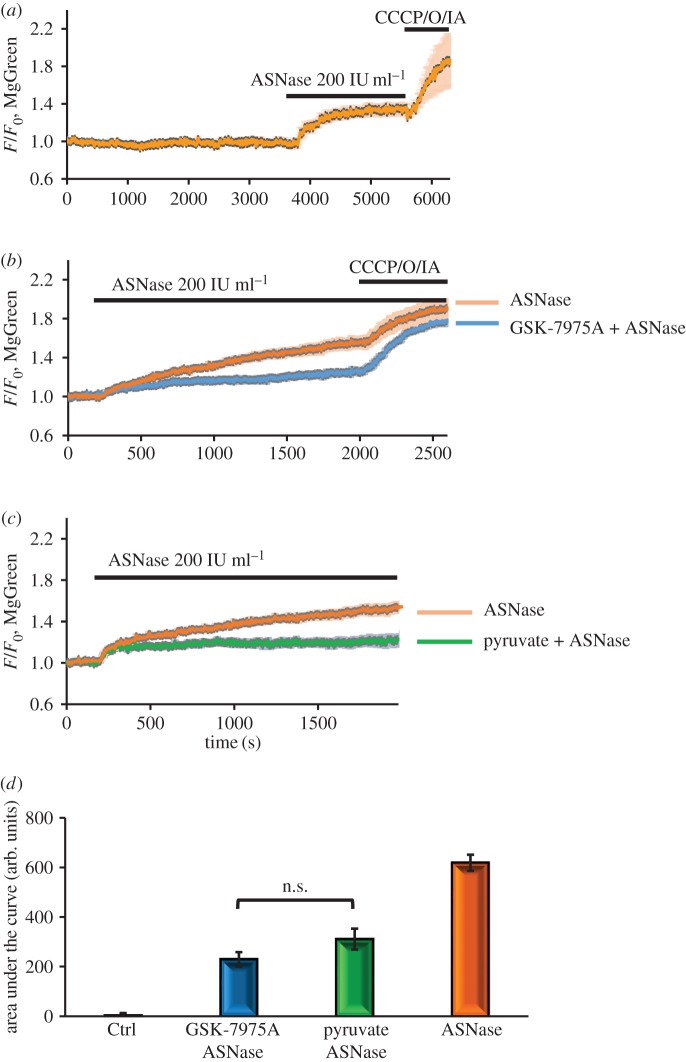
Asparaginase reduces intracellular ATP levels as assessed by increases in [Mg2+]i. In these experiments, changes in [Mg2+]i were assessed by monitoring changes in MgGreen fluorescence. Most of the Mg2+ inside cells is bound to ATP, so when ATP declines—for example owing to interference with mitochondrial function—[Mg2+]i will increase. A rise in [Mg2+]i can therefore be taken to represent a reduction in the intracellular ATP level [58]. Asparaginase (200 IU ml−1) markedly increased [Mg2+]i and a further rise occurred after poisoning mitochondrial function with a cocktail of CCCP (5 nM), oligomycin (10 µM) and sodium iodoacetate (2 mM; a, averaged trace, n = 39). The asparaginase effect was markedly reduced by GSK-7975A (b: orange averaged trace, n = 21; blue averaged trace, n = 39) and was also markedly reduced by supplementing the external medium with pyruvate (1 mM; c, n = 8). Comparisons of the integrated responses (‘areas under the curve’ from the start of the responses until 1800 s later) show that GSK-7975A and pyruvate significantly reduced the asparaginase-induced ATP depletion (p < 0.0001 for both treatments).